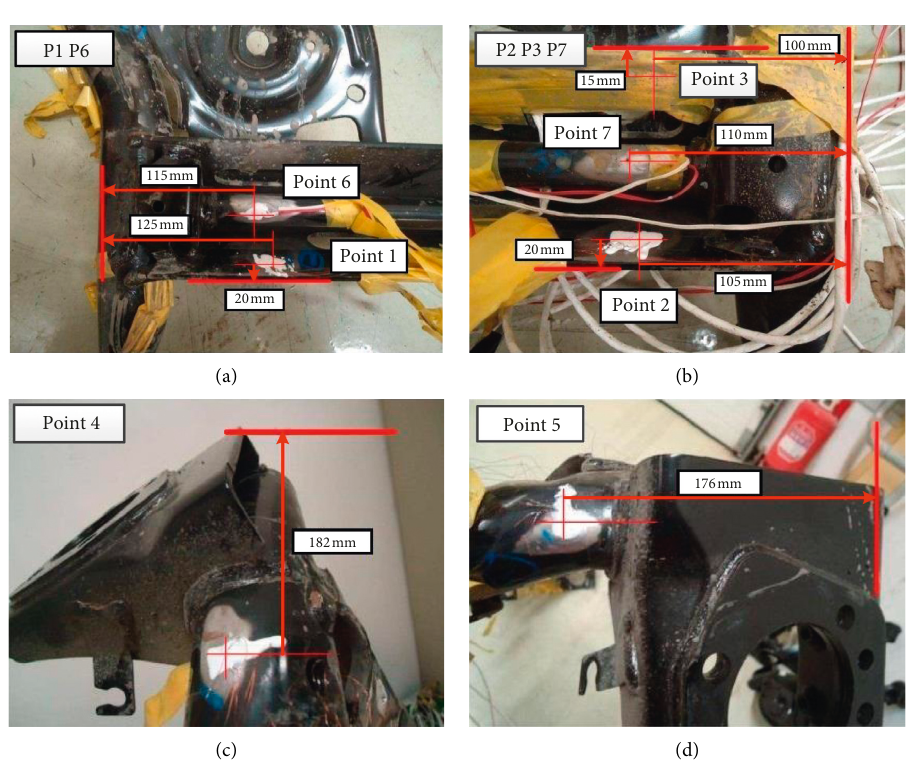
Figure 4: Measurement positions on the